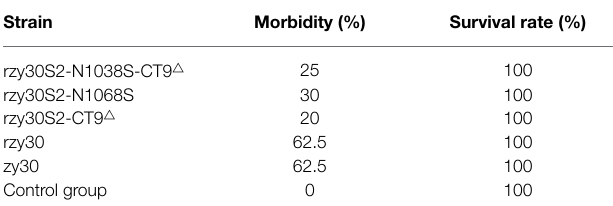
TABLE 2 | Comparison of pathogenicity between rescued IBV and zy30 strains.